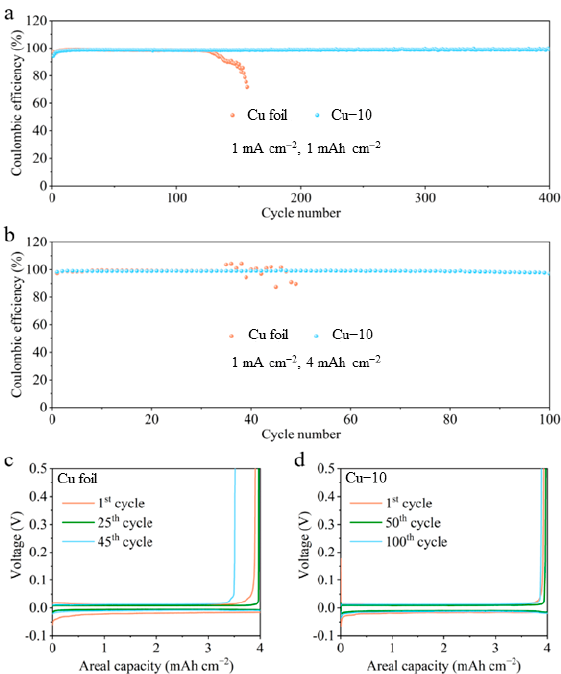
Figure 5. Coulombic efficiency of the cells using the commercial Cu foil and Cu − 10 at 1 mA cm − 2 with the capacity of ( a ) 1 mAh cm − 2 and ( b ) 4 mAh cm − 2 . The corresponding voltage profiles of the cells using the ( c ) commercial Cu foil and ( d ) Cu − 10 at different cycles with the capacity of 4 mAh cm − 2 .